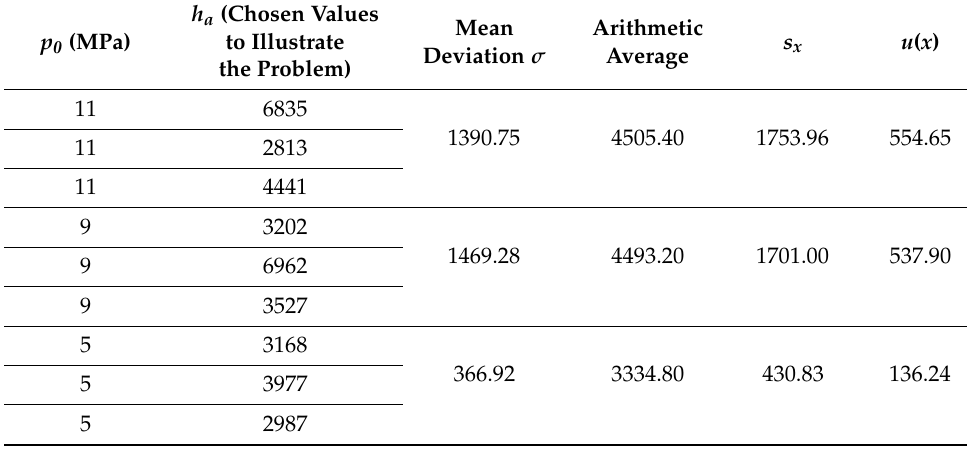
Table 1. Selected test results for the parameter h a , determined by mean deviation σ , arithmetic average, standard deviation estimator s x and measurement uncertainty u ( x ).